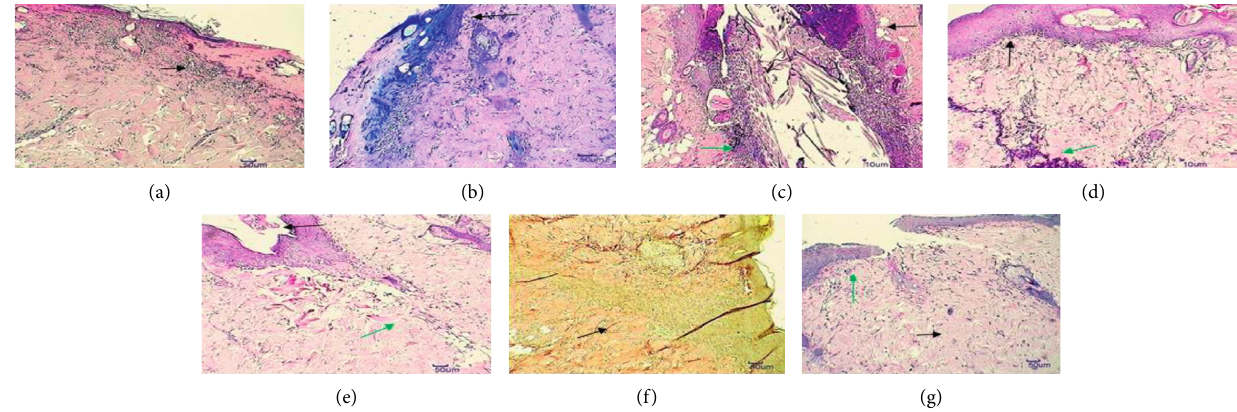
Figure 5: Histopathological indications on braided silk sutured skin area sections. (a) 24hrs—H and E 10x, necrosis of epidermal and dermal cells with scab formation and mild neutrophilic infiltration. (b) 48 hrs—Giemsa 10x, epithelial cell migration with moderate neutrophilic infiltration. (c) 72hrs—H and E 10x, epidermal proliferation, mild granulation tissue invasion. (d) 96hrs—H and E 10x, epidermal layer thickening, mild granulation tissue formation. (e) 120Hrs—H and E 10x, severe epidermal keratinization, moderate collagen production. (f) 144hrs—van Gieson 10x, diffuse moderate collagen production. (g) 168 hrs—PAS 10x, severe collagen production, moderate neovascularization in the